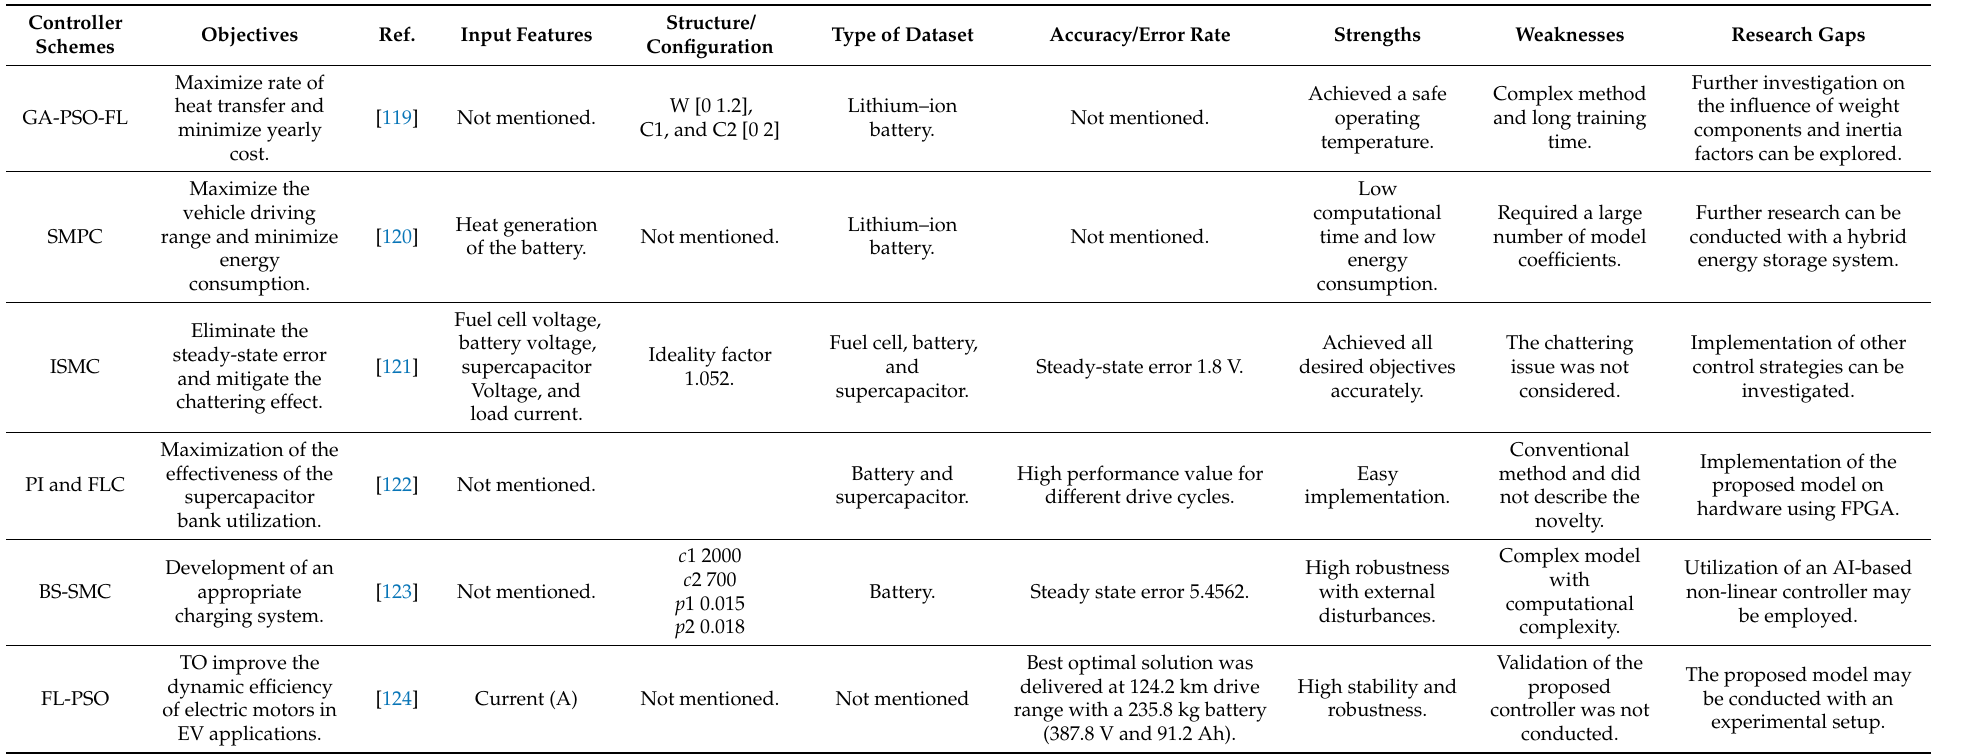
Table 7. Controller schemes for BMS in